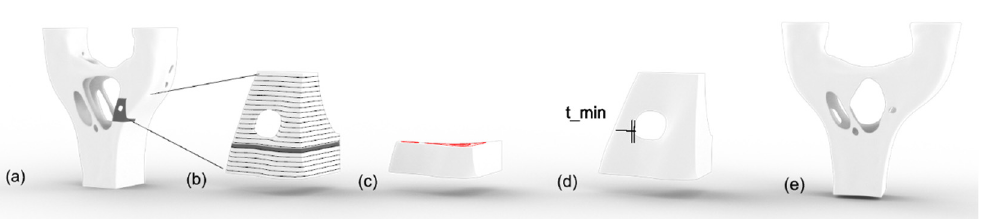
Figure 7. Exemplary representation of the process for finding the manufacturing restrictions for the DED-arc setting used ( a ) Initial design of the node, ( b ) cutout used as Case Study Demonstrator, ( c ) first 14 layers of the demonstrator with tool path, ( d ) location of the constraint “minimal wall thickness”, ( e ) optimized node.